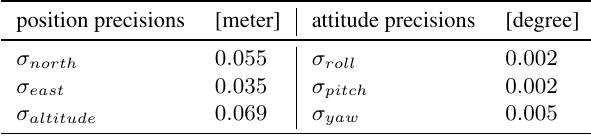
Table 5. Precisions of Exterior Orientations